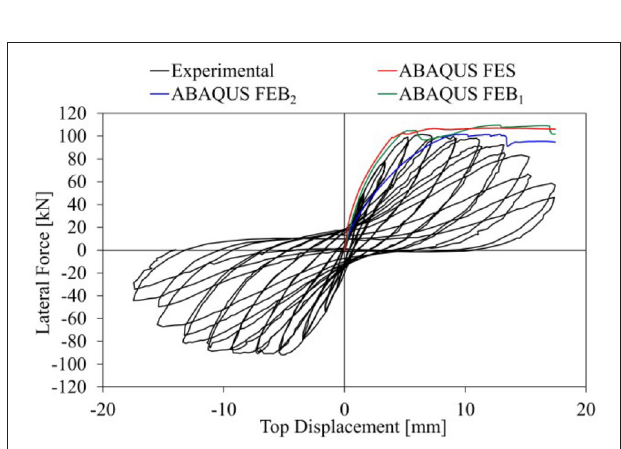
FIGURE 7 | Comparison between the monotonic response of the three FE model developed and the cyclic experimental response of